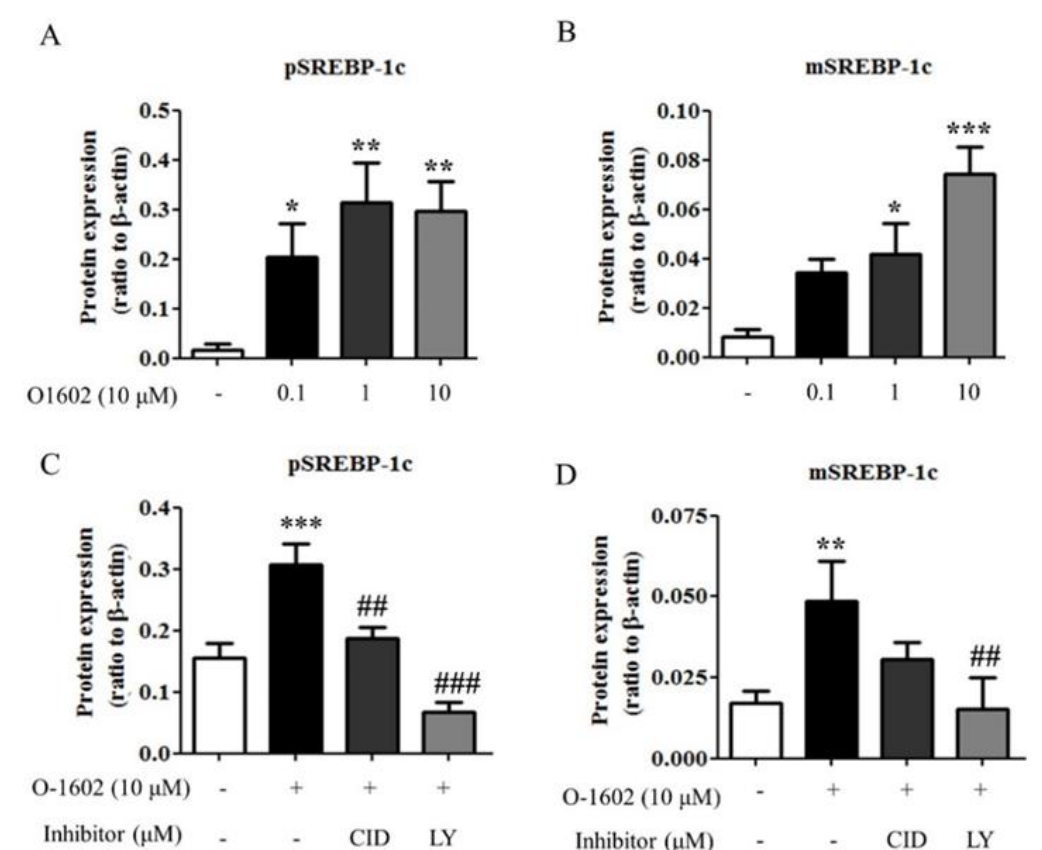
Figure 5. O-1602 induces SREBP-1c protein expression through GPR55 and PI3K. Hep3B cells were treated with different concentrations of O-1602 for 48 h. Western blot analysis was performed for SREBP-1c in Hep3B cells. ( A , B ) Quantitative western blot analysis of SREBP-1c preform ( A ) and mature form ( B ). Hep3B cells were pretreated with CID16020046 or LY294002 for 30 min and then treated with 10 µ M O-1602 for 48 h. ( C , D ) Quantitative western blot analysis of SREBP-1c preform ( C ) and mature form ( D ). Data are from three individual experiments and expressed as mean ± SD. * p < 0.05, ** p < 0.01, *** p < 0.001, compared with the non-treated group; ## p < 0.01, ### p < 0.001, compared with O-1602-treated group.